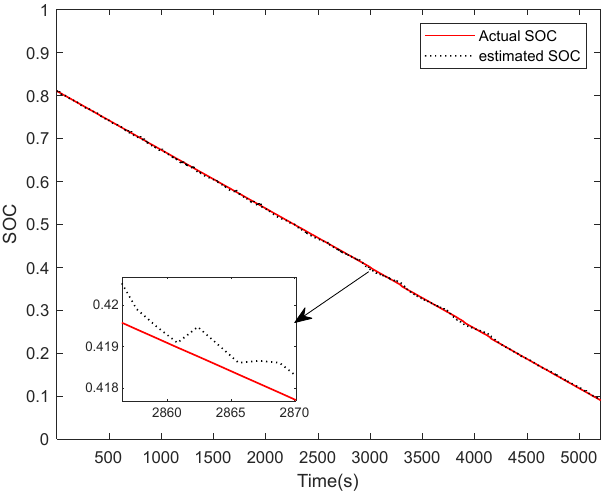
0.0047, respectively.